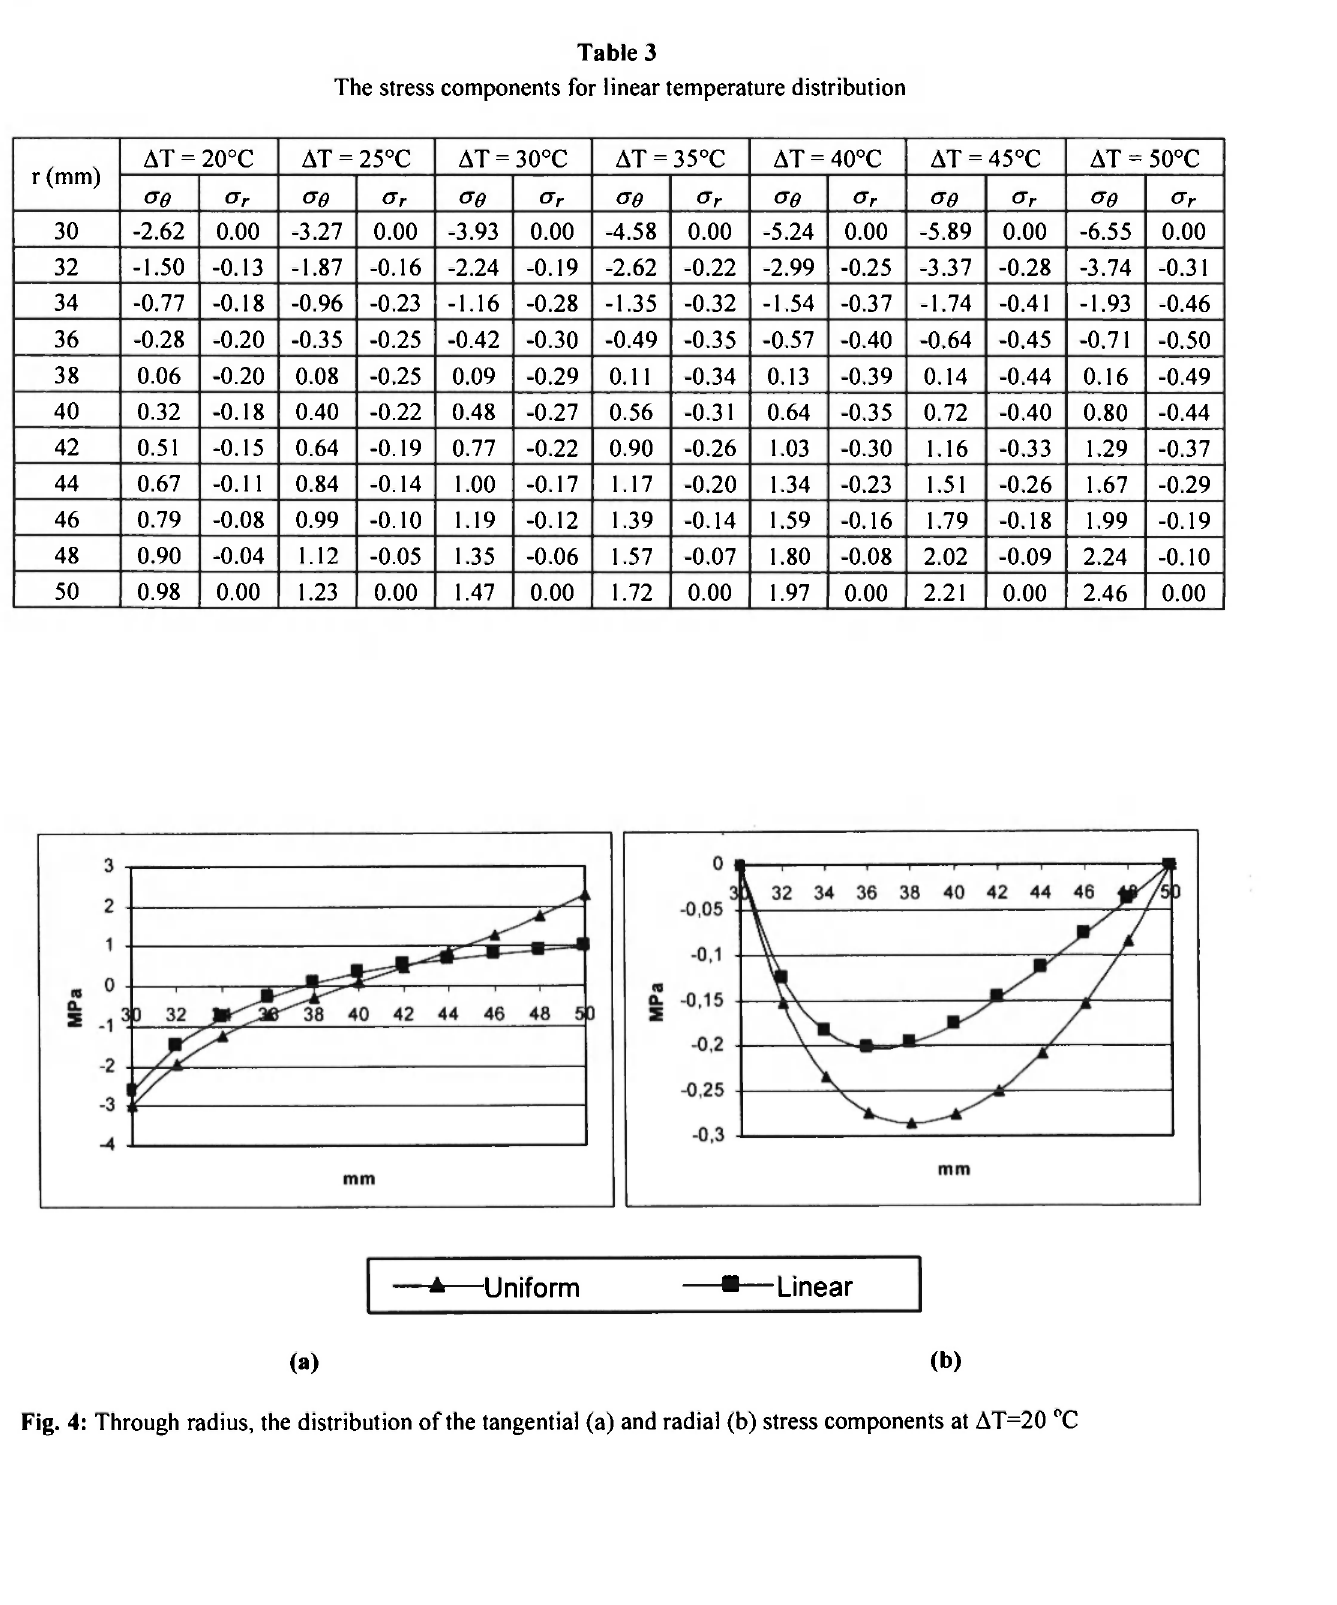
Fig. 4: Through radius, the distribution of the tangential (a) and radial (b) stress components at ΔΤ=20